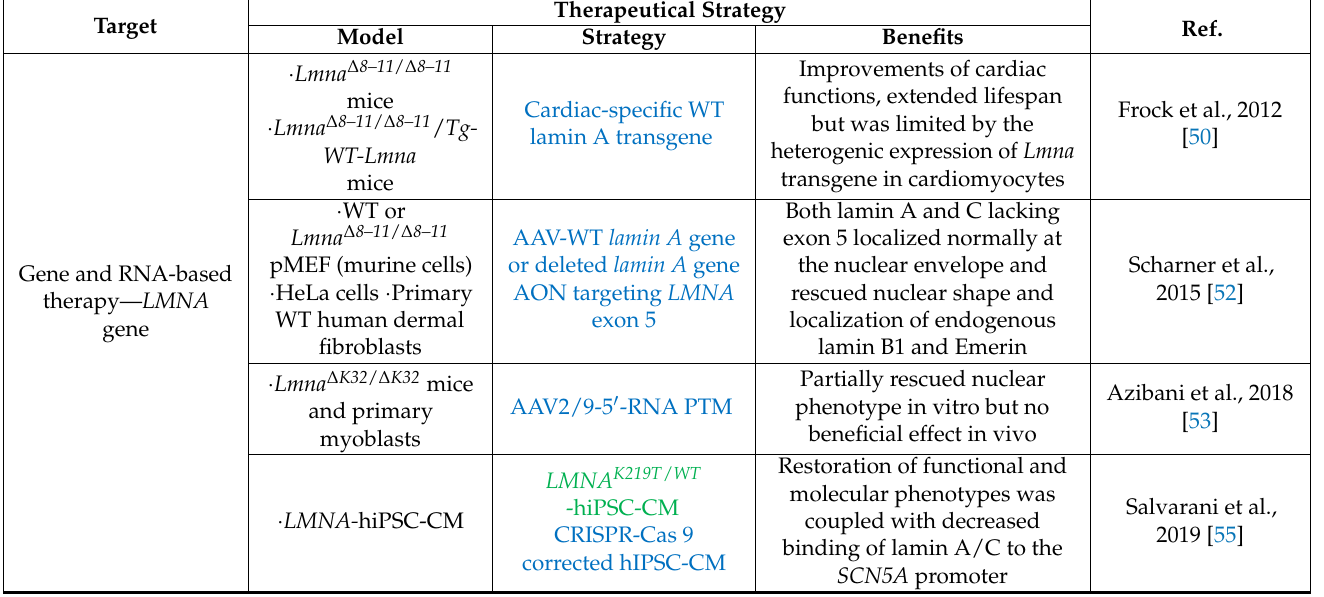
Therapeutical Strategy